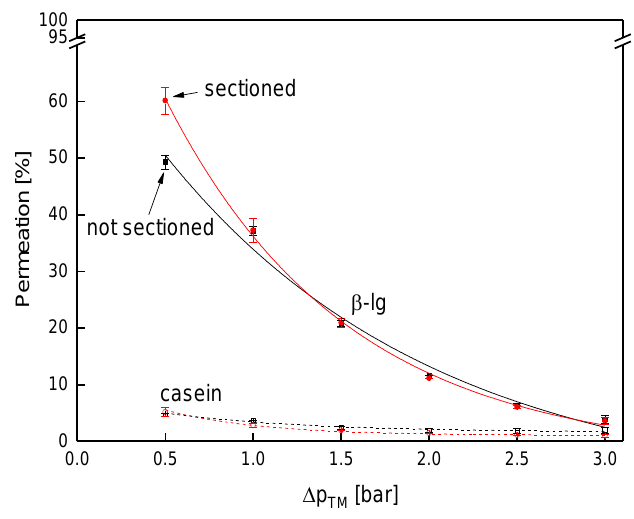
Figure 9. Protein permeation as a function of the ∆ p TM for the sectioned and the non-sectioned SWM (length of 0.96 m) at a mean crossflow velocity of 0.42 m s − 1 .